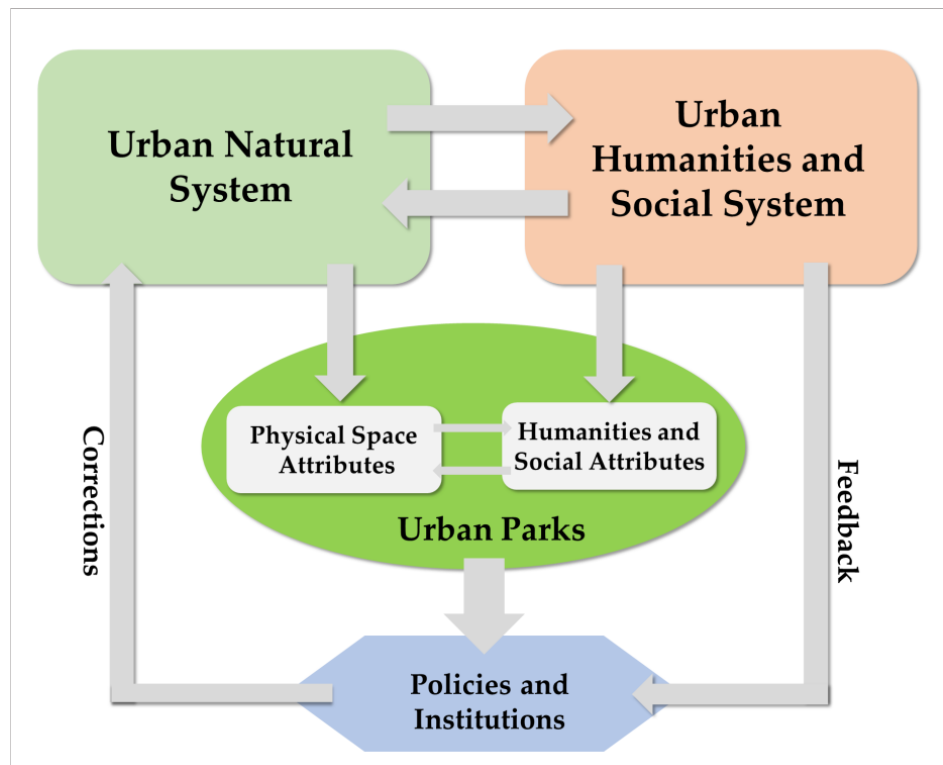
Figure 1. Interaction between natural and social systems.